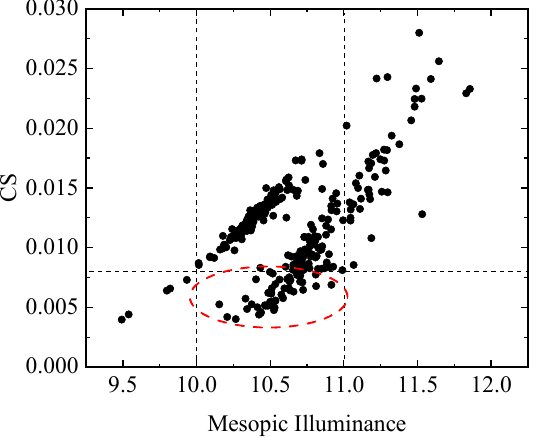
Figure 8. CS as a function of mesopic illuminance at 10 lx. Within the red dashed circle, CSs stay at a relatively low level, but mesopic illuminance increases.